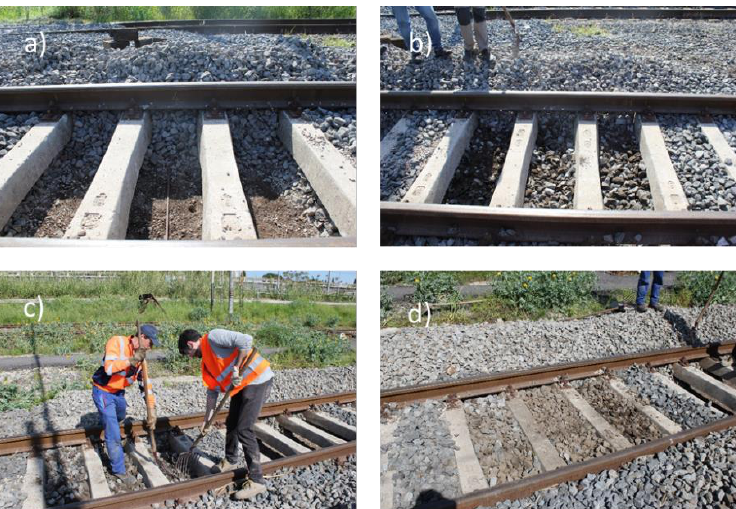
Figure 3. Preparation of a single sub-section within the test-site area; ( a ) a set of three slots is emptied out of the original ballast; ( b ) the slots are filled up again with the test material; ( c ) the material is arranged and compacted in order to fill all the voids; ( d ) the re-arranged configuration.